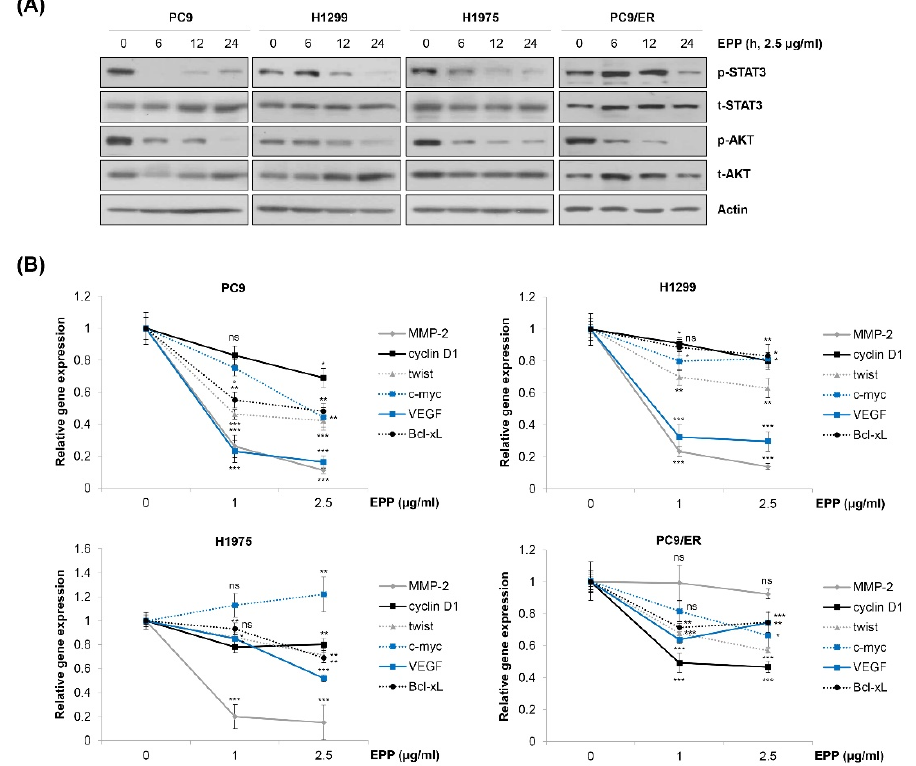
Figure 4. Inactivation of STAT3 and AKT by EPP in human NSCLC cell lines with different EGFR mutation statuses. ( A ) H1299, PC9, H1975, and PC9/ER human NSCLC cells were